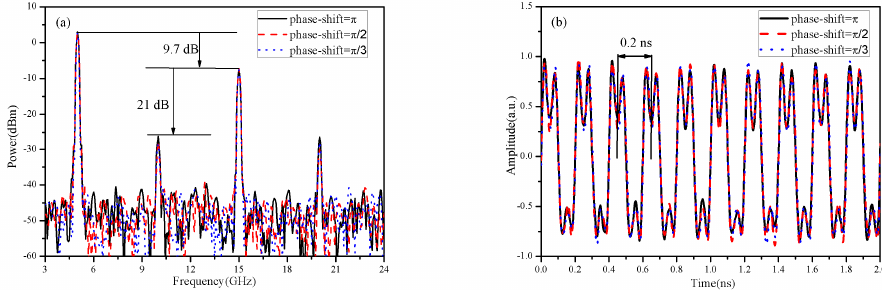
Figure 7. The generated square waveform with a repetition rate of 5 GHz for different phases. ( a ) The spectrum and ( b ) waveforms of the generated signals.